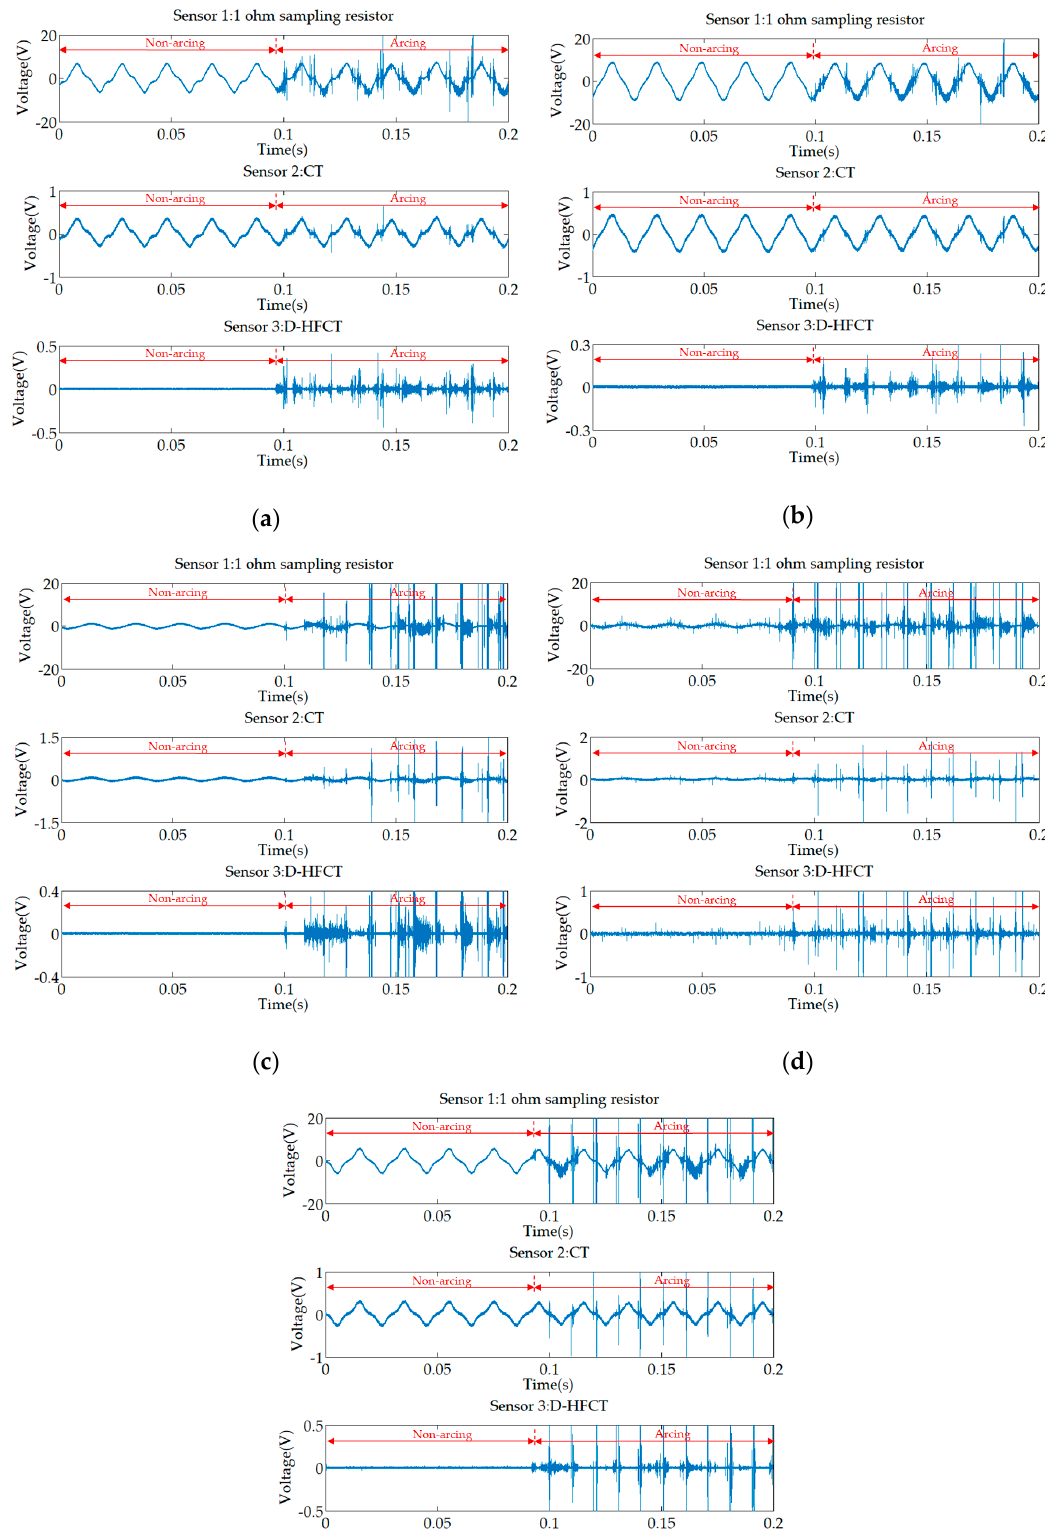
Figure 22. Experimental waveforms of inductive loads. ( a ) Air compressor; ( b ) vacuum cleaner; ( c ) refrigerator; ( d ) electric drill; ( e ) electric hammer.